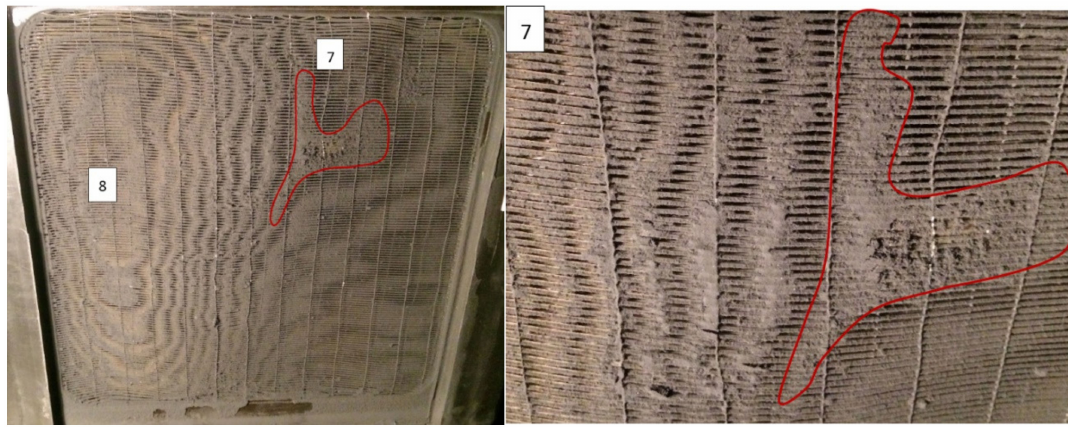
Figure 7. Heat exchanger surface after injection of 2800 g m − 2 of test dust ( left ); and magnification of the highly fouled zone 7 with complete blockage of the surface ( right